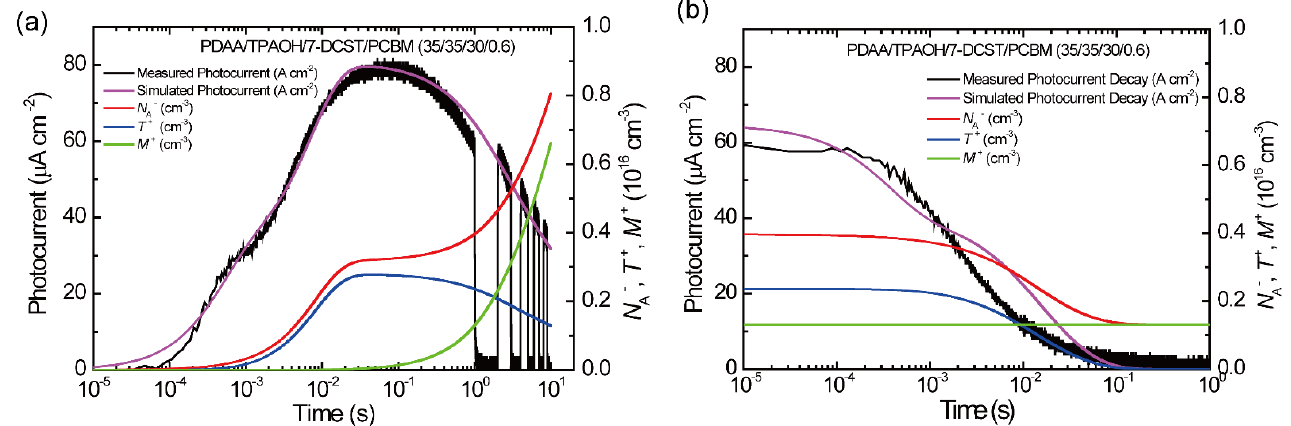
Figure 5. ( a ) Rising transient photocurrent (black plots) and the simulated photocurrent (pale purple curve) for PDAA/TPAOH/7-DCST/PCBM: red curve, transient density for the sensitizer anion N A − ; blue curve, transient density for filled shallow traps T + ; green curve, transient density for filled deep traps M + ; ( b ) decay profile.